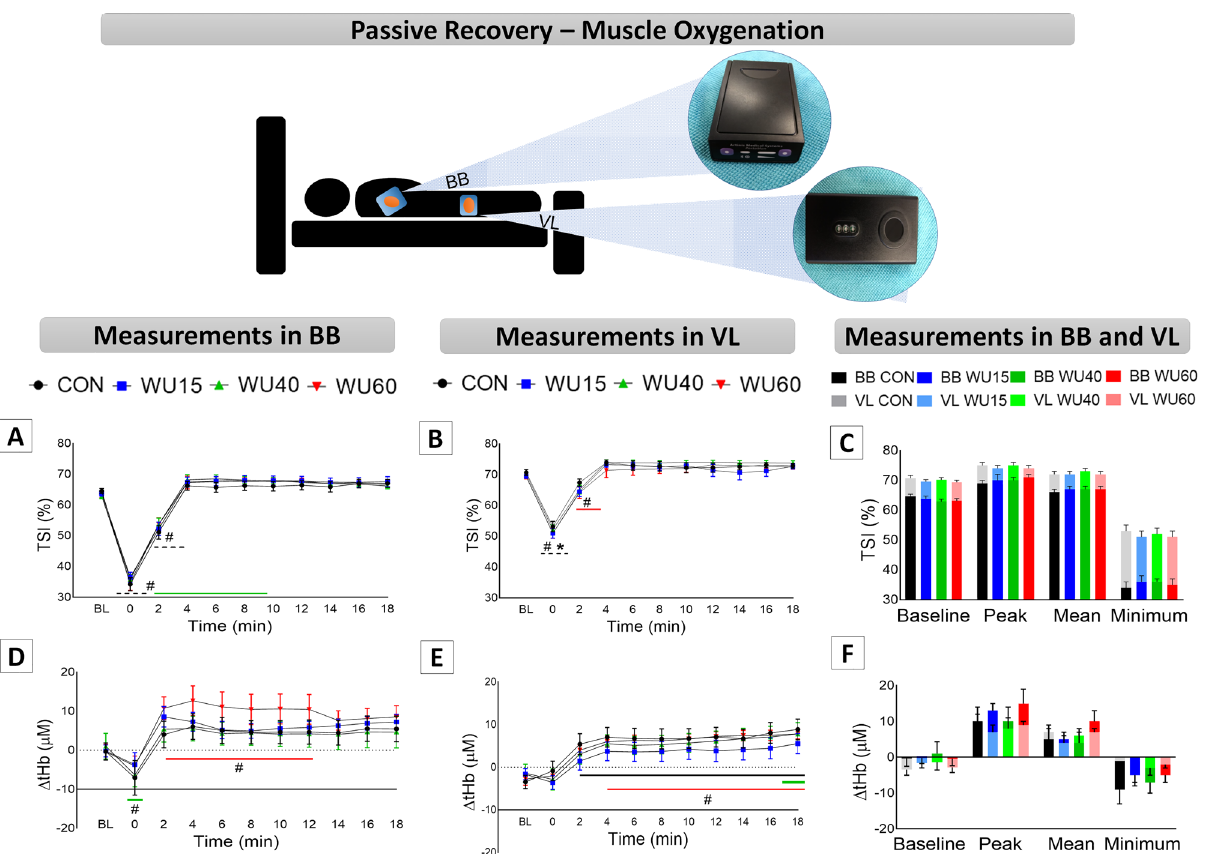
Figure 5. Results of tissue saturation indexes (TSI, Panels A–C ) and total hemoglobin ([tHb], Panels D–F ) in passive recovery immediately after the 30 s all-out run (T0) and every 2 min up to 18 min (T2–T18) compared to BL values. Timeline panels show the biceps brachii (BB) and vastus lateralis (VL) under control conditions (CON, black color) and after the IMW loads with 15% (WU15, blue color), 40% (WU40, green color) and 60% of MIP (WU60, red color). Bar graphs present the peak, mean and minimum values (mean ± SEM), with dark colors for BB and light colors for VL. MIP = maximum inspiratory pressure. # corresponds to difference compared to baseline (BL); * means significantly different from BB. Dashed line means no differences among protocols. Colored line means differences in a specific